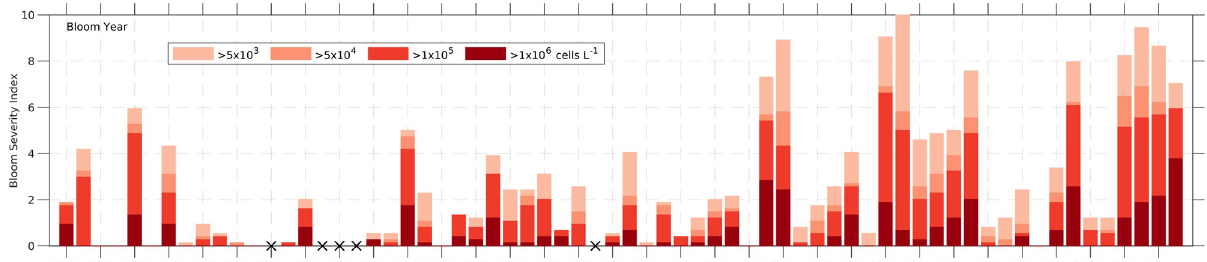
Fig 3. Bloom severity index for 25.4˚ to 28.4˚ N for each bloom year. The annual severity index is determined for the bloom year defined as August to the following July and uses the data accumulated from Fig 2B. The annual bloom index was normalized by the largest bloom year so it fell into the scale of 0–10 (0 indicates no bloom; 10 is the largest bloom). Black Xs on the X-axis show bloom years with no available